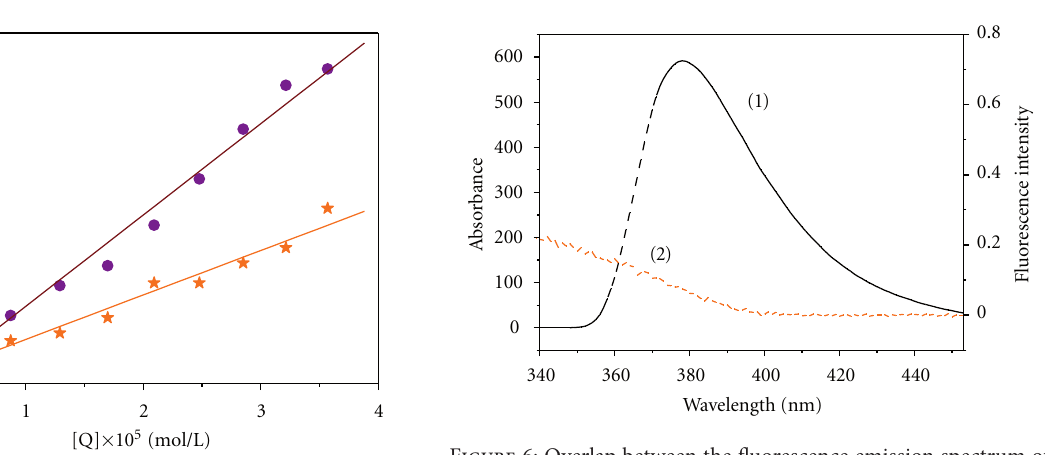
F 6: �verlap between the �uorescence emission spectrum of BSA (1) and UV absorption spectrum of Evo (2), BSA Evo M, K. 𝐸 𝐶𝐶 𝐸 𝐶𝐶 𝐸0𝜇𝜇 𝑇𝑇 𝐸 2𝑇8 , and of BSA with Evo, T 3: e calculated values of is the correlation 𝑅𝑅 𝐽𝐽